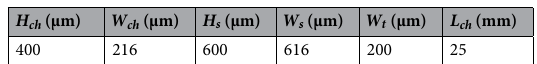
Table 1. Dimensions of the computational domain.